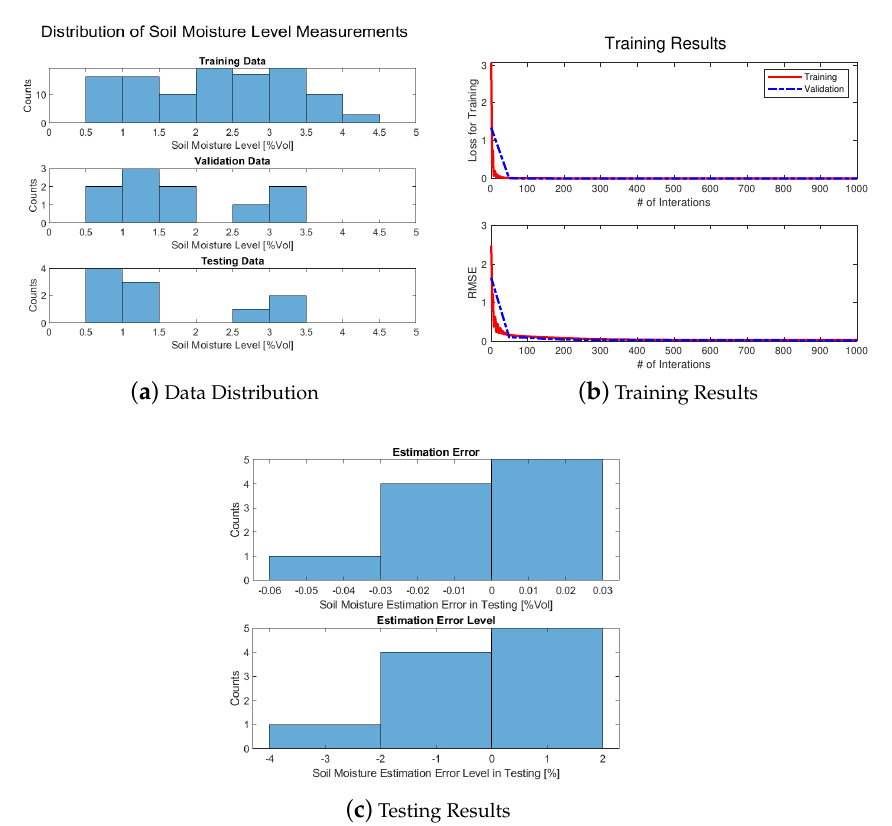
Figure 8. Training, validation, and testing results for soil moisture